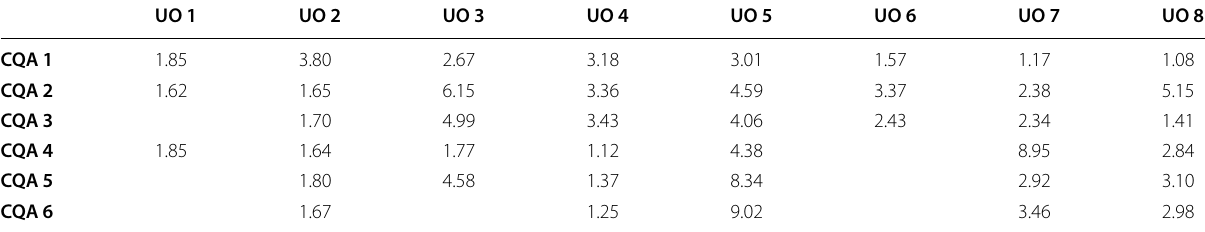
Table 2 LMM/OLS tolerance interval width ratios for 6 of the most common CQAs per unit operation. Due to the strong random effect, the LMM interval is generally much wider than the OLS